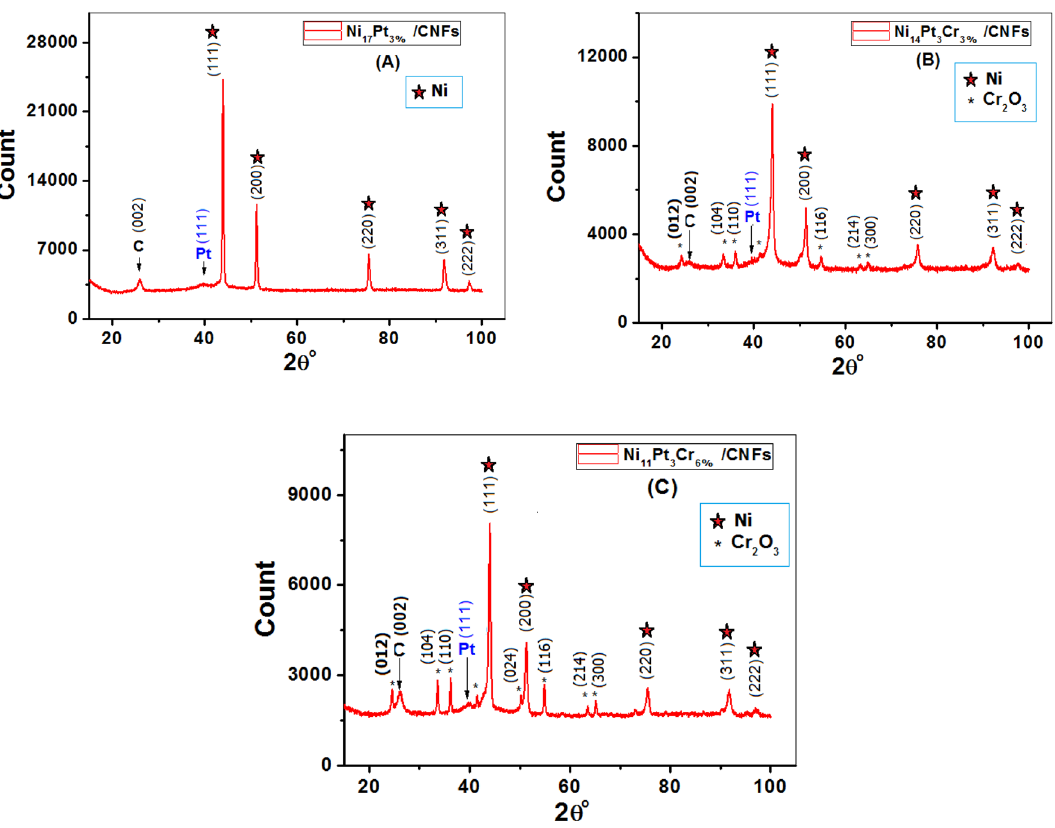
Figure 5. XRD patterns of CNFs/Ni 17−x Cr x -Pt 3% nanoparticles [( A ) x = 0, ( B ) x = 3 and ( C ) x = 6%].